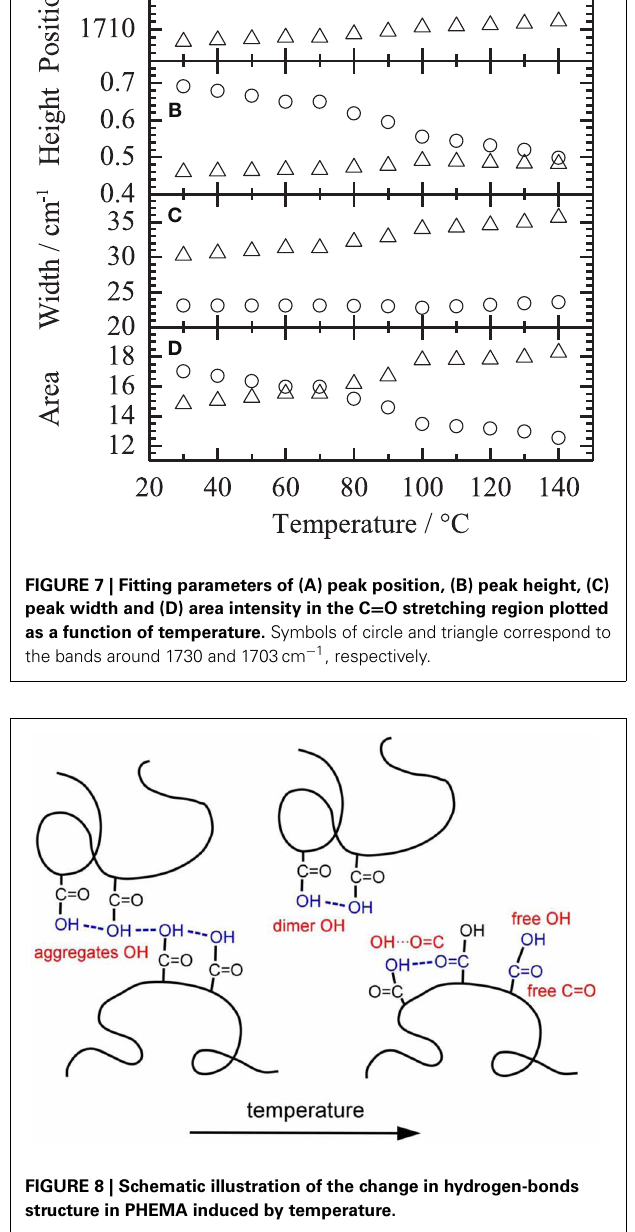
C=O STRETCHING REGION